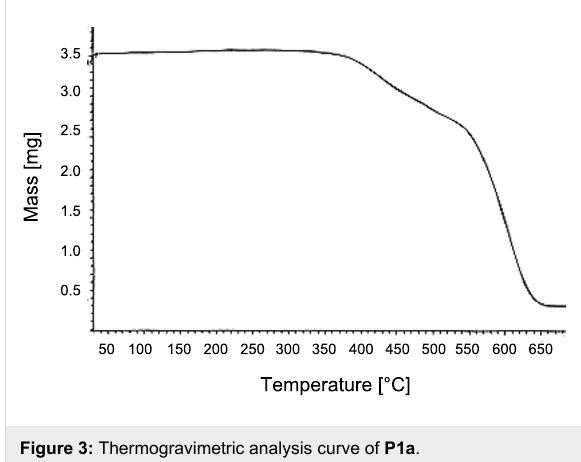
Figure 3: Thermogravimetric analysis curve of P1a .